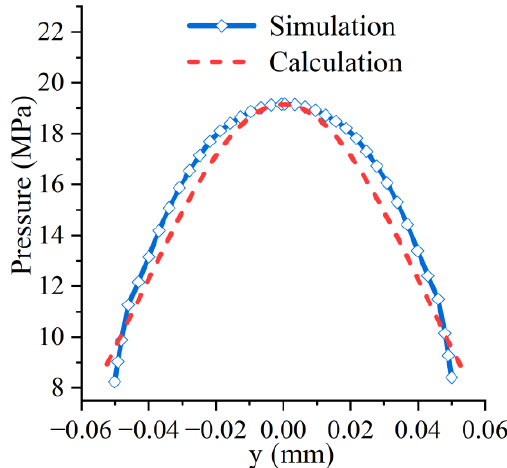
Figure 17. Comparison of impact pressures on the shunt wedge.